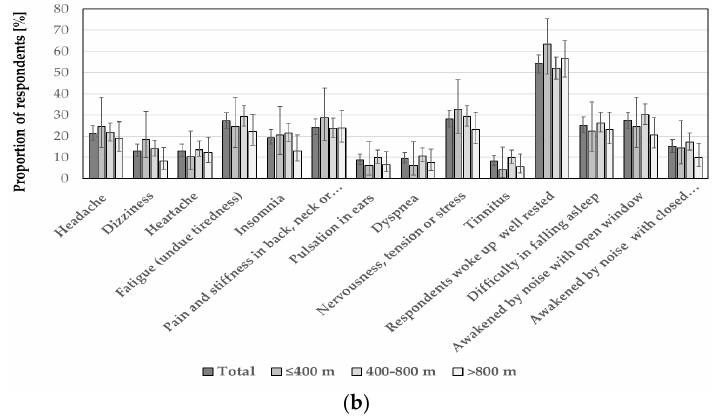
Figure 6. The prevalence of various health and well-being aspects in total and in each of the: ( a ) noise and ( b ) distance categories. Data are presented as proportions with 95% confidence intervals. There were no significant differences between various noise and distance categories ( p > 0.00167). Table 7. Proportions of respondents (with 95% confidence intervals) who assessed their physical health negatively, being categorized as “cases” based on the GHQ-12 score, and frequently reported various complaints in total and in subgroups of subjects annoyed and not annoyed by the wind turbine noise 1 .